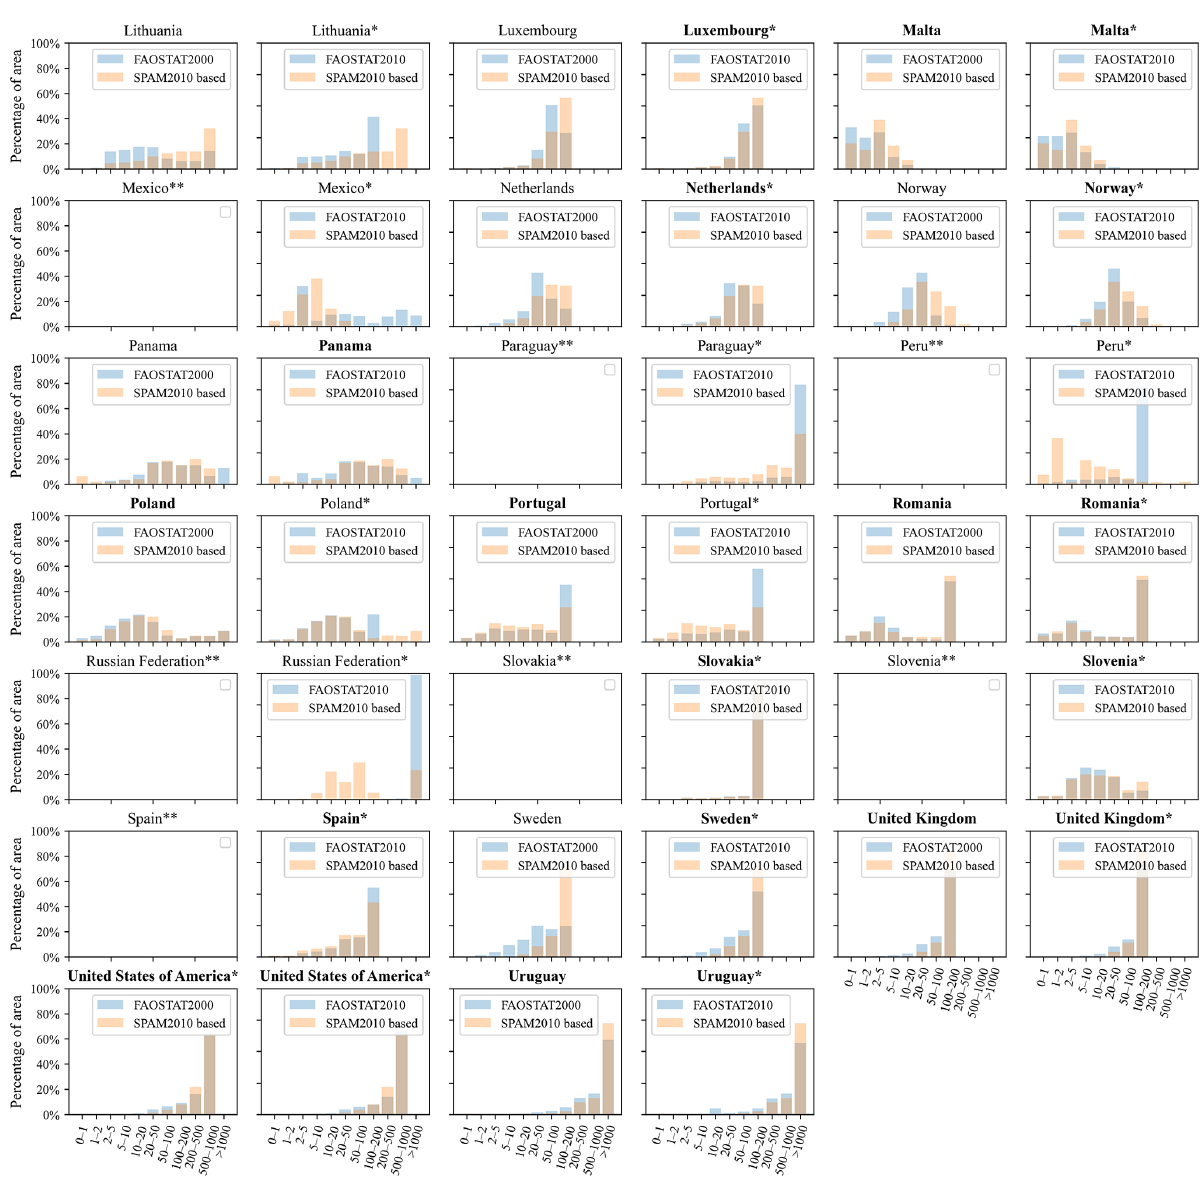
Figure A3. Comparison of the percentage of total crop area operated by each farm size (non-crop-specific farm size structure) between FAO- STAT structural data for the year 2000 and 2010 (FAO, 2022) and our farm-size-specific and crop-specific dataset based on the SPAM2010 crop map. Bold font country titles indicate that farm size structures in FAOSTAT are similar to our dataset. Note that for the year 2000, farm size structure from FAOSTAT structural data is the same as Lowder et al. (2016) except for one country (Fig. S5). Only the countries covered by our dataset and FAOSTAT are shown. The alternative version based on the GAEZv4 crop map is given in Fig. 7. * FAOSTAT provides (part of) the structural data by interpolating other reported data, not directly from countries’ official reports. ** FAOSTAT provides no farm size structural data of the year 2000 or 2010 for